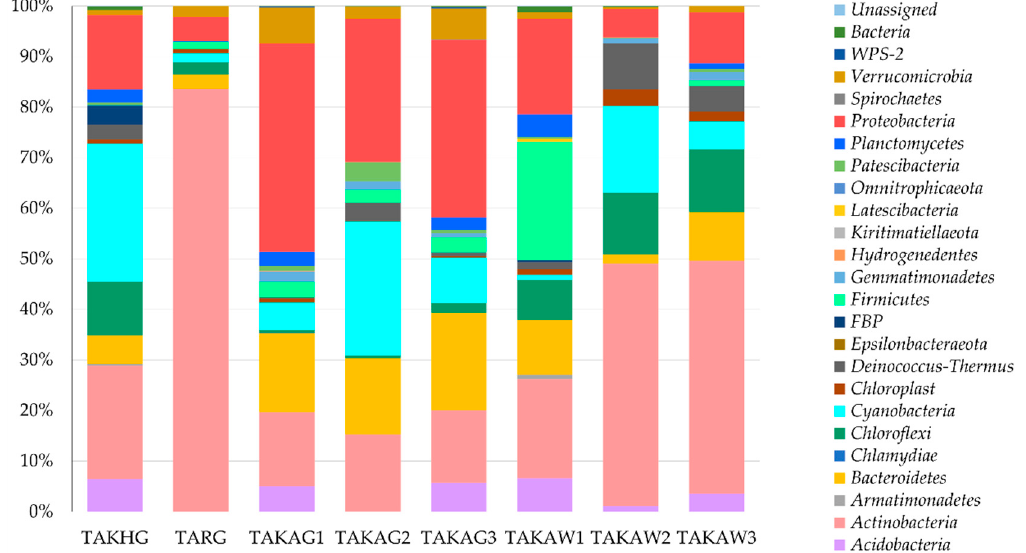
Figure 3. Structure of endolithic microbial communities at the phylum level based on the V3–V4 hypervariable region of 16S rRNA gene.